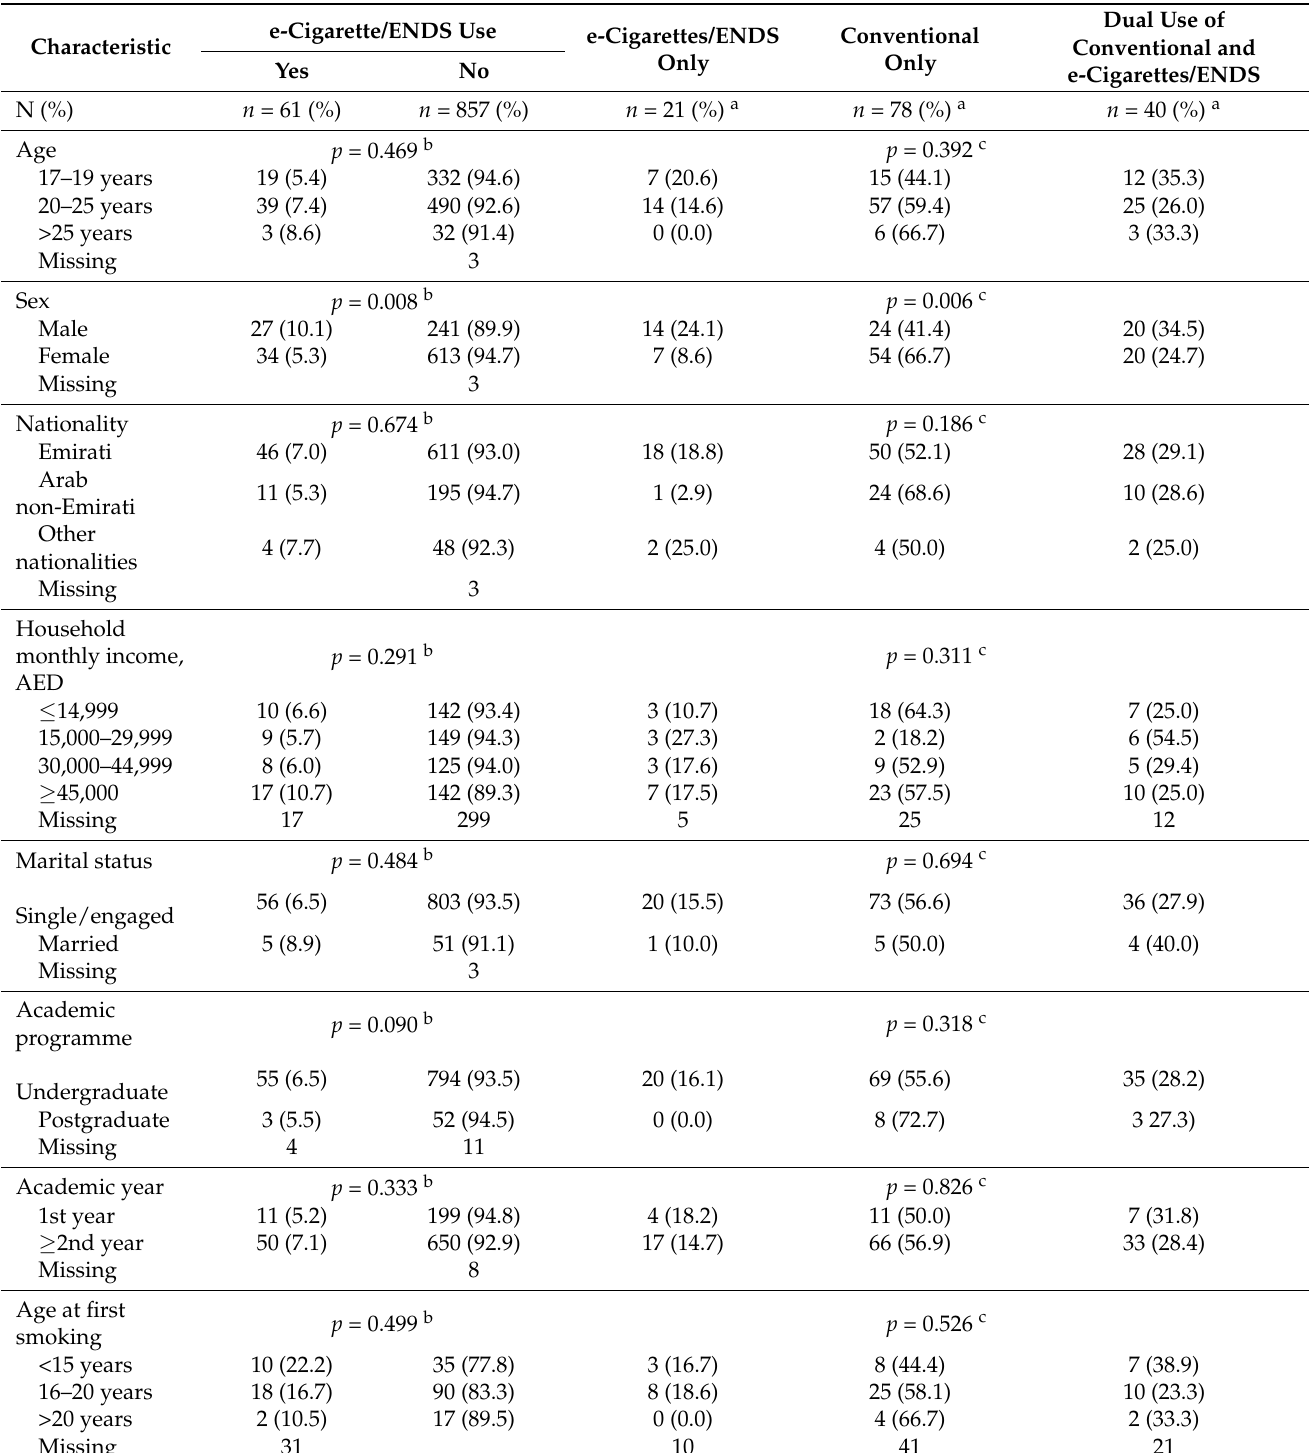
Table 2. The distribution of single and dual of conventional smoking and e-cigarettes/ENDS use by the students’ sociode- mographic and academic